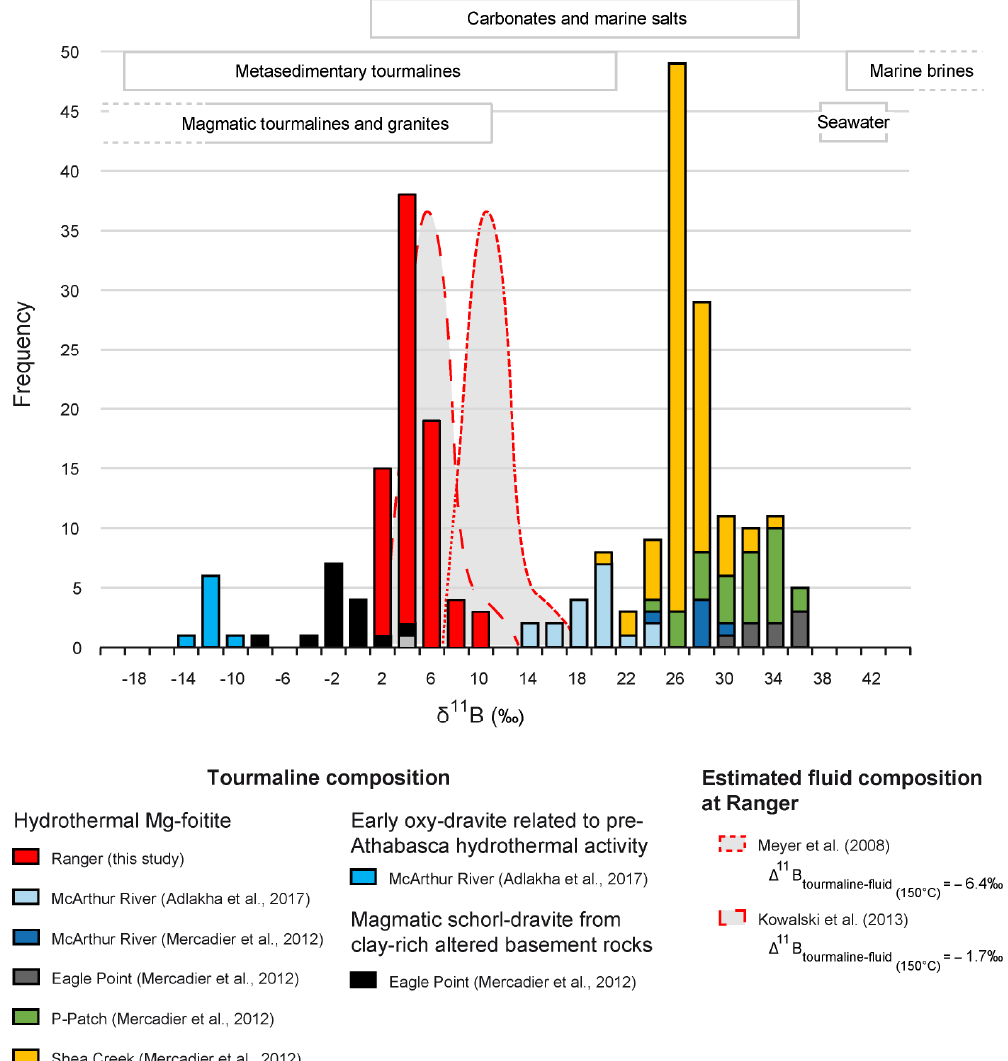
Figure 9. Histogram of boron isotopic compositions for tourmaline T1 at Ranger U deposit (this study) and for some of the unconformity‐related U deposits from the Athabasca Basin (Canada): Adlakha et al. [32] and Mercadier et al. [33]. The boron isotopic composition for different B reservoirs are shown ([62–64] and references therein). The range of the boron isotopic composition of the calculated fluid in equilibrium with tourmaline T1 at Ranger is indicated by a grey zone limited by a red dotted line according to two independent methods: Meyer et al. [65] and Kowalski et al. [66].